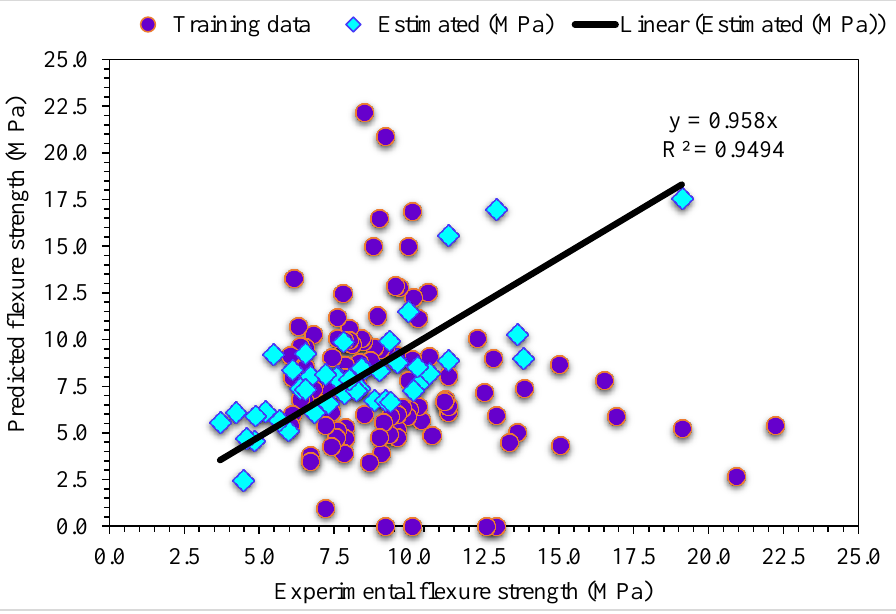
Figure 10. Experimental and MLPNN-AdaBoost predicted results for flexural strength.